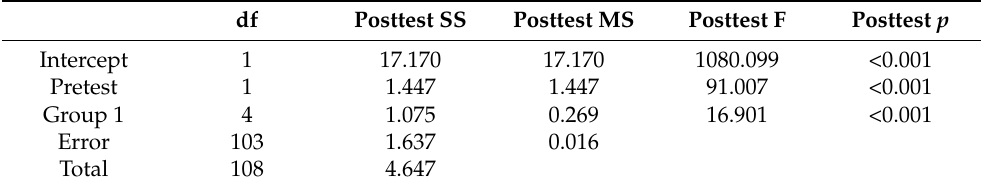
Figure 6. Scatter plot for the groups: ( a ) conBc; ( b ) expBc; ( c ) conM; ( d ) expM; ( e ) expPhD. Table 8. The analysis of covariance with the pretest control and taking into account the degree of